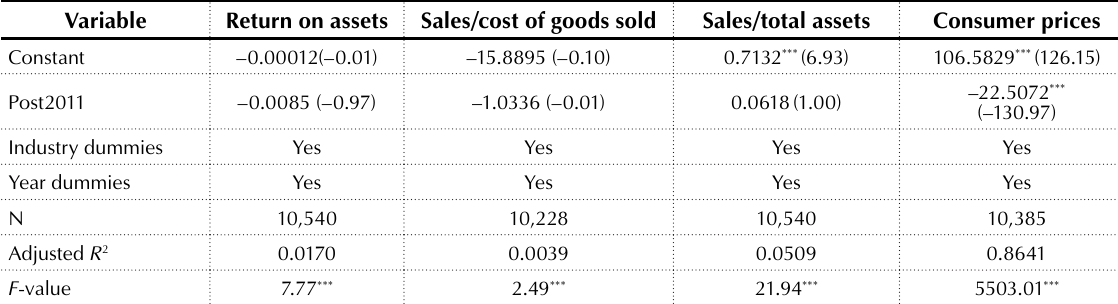
Table 5. Regression results for tax shifting